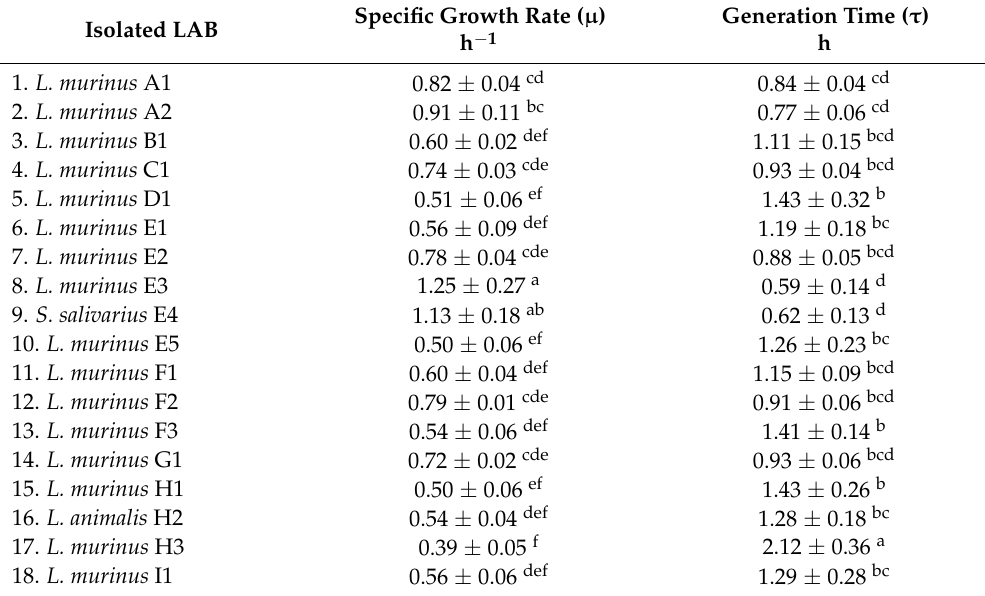
Table 3. Kinetic parameters of the isolated LAB strains. Data are expressed as a mean and standard deviation. abcdef shows a significant difference per column